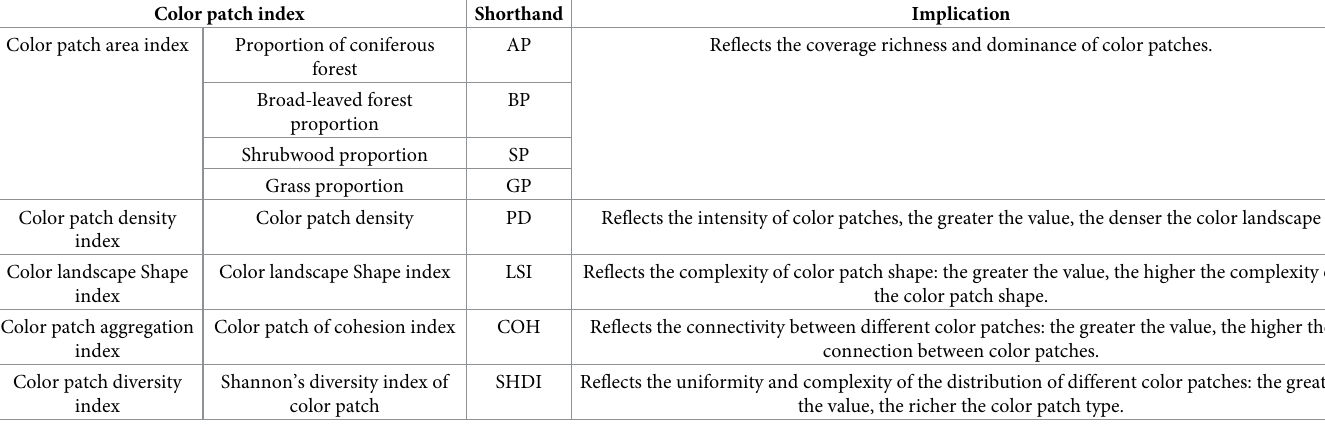
Table 1. Spatial composition index of color